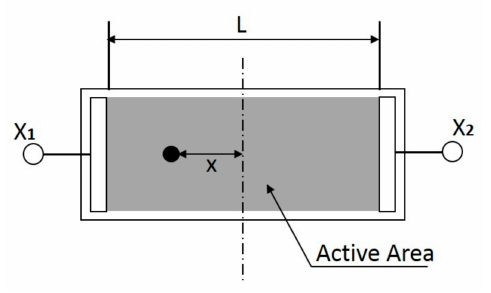
Figure 1. Schematic of a position sensitive detector (PSD).